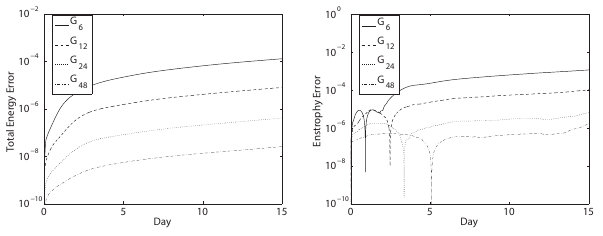
Figure 11. Normalized conservation errors of total energy and po- tential enstrophy on refined grids for case 5. removed through a numerical treatment which balances the numerical flux and topographic source term (Chen and Xiao, 2008). The numerical results on finer grids are not depicted here since they are visibly identical to the results shown in Fig. 9. Present model assures the rigorous conservation of the total mass as shown in Fig. 10. The conservation errors of total energy and enstrophy are of particular interest for eval- uating the numerical dissipation of the model. As shown in Fig. 11, the conservation errors for total energy (left panel) and potential enstrophy (right panel) of tests on a series of refined grids are checked. As in the above case, to compare with our former fourth-order model this test case is checked on grid G 20 having the similar DOFs as the former 32 × 32 × 6 grid. The conservation errors are − 9 . 288 × 10 − 7 for total en- ergy and − 1 . 388 × 10 − 5 for potential enstrophy and much smaller than those by fourth-order model in Chen and Xiao